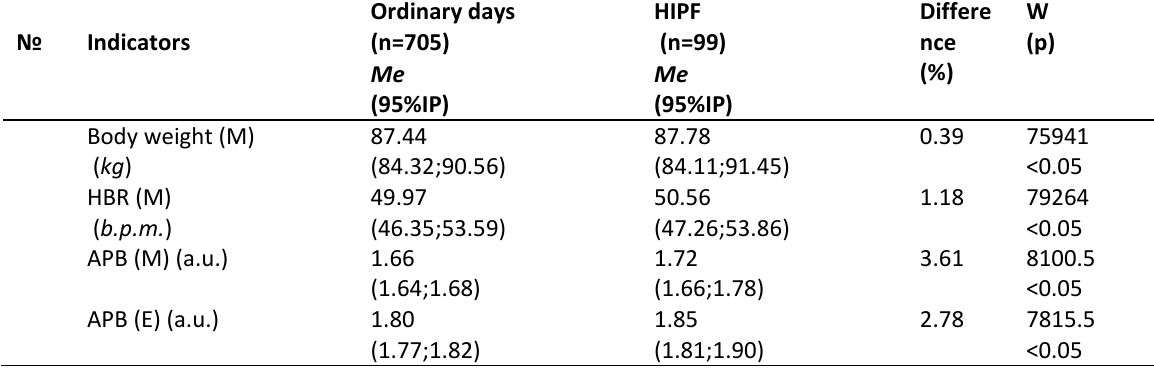
Table 1. Comparison of men’s PC indicators in ordinary days and in days with highly intensive physical functioning